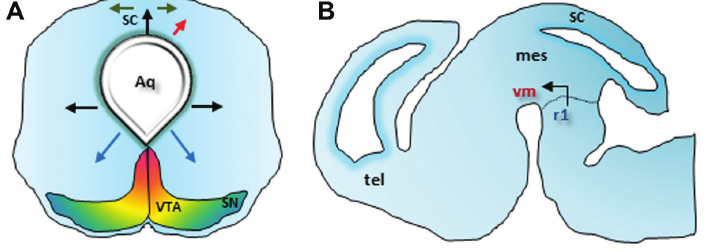
(A) Coronal view of embryonic mesencephalon showing different patterns of neuronal migration. Black arrows depict radial migration of GABA neurons from the VZ to their final location. Green arrows indicate slight tangential dispersion within the superficial layer of the SC. Red arrow depicts that few cells show direct tangential migration from VZ to the superficial layer of the SC. Blue arrows highlight perpendic- ular migration of GABA neurons from basal plate region to ventral mesencephalon. (B) Sagittal view of embryonic mesencephalon depicting migration of postmitotic GABA neuronal precursors that cross the specific mesencephalon-rhombomere1 (r1) boundary to enter from r1 into the ventral mesencephalon (vm). The mode of migration of these neurons with origins outside the mesencephalon is currently unknown. tel, Telencephalon; mes, Mesencephalon; SC, superior